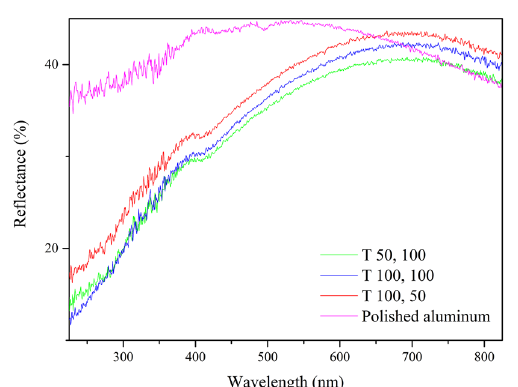
Figure 7. UV-Vis reflectance spectrum of the prepared surfaces under conditions